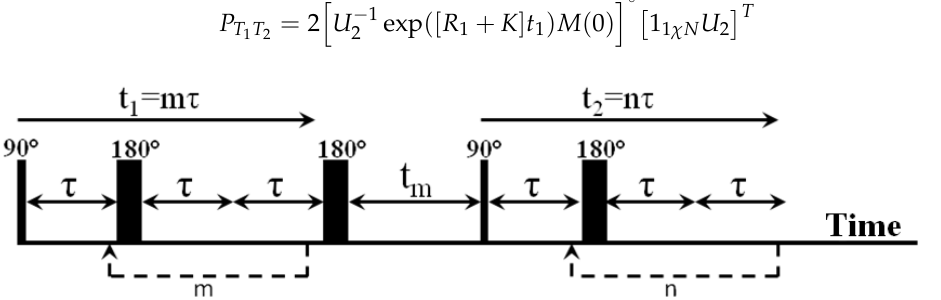
Figure 4. The RRCOSY pulse sequence used in the experiment consisting of two 90° and three 180° radio frequency pulses, where t 1 is the time of the indirect encoding period, t 2 is the time of the detection period, t m is the mixing time, m and n are the numbers of echo times in the encoding periods.